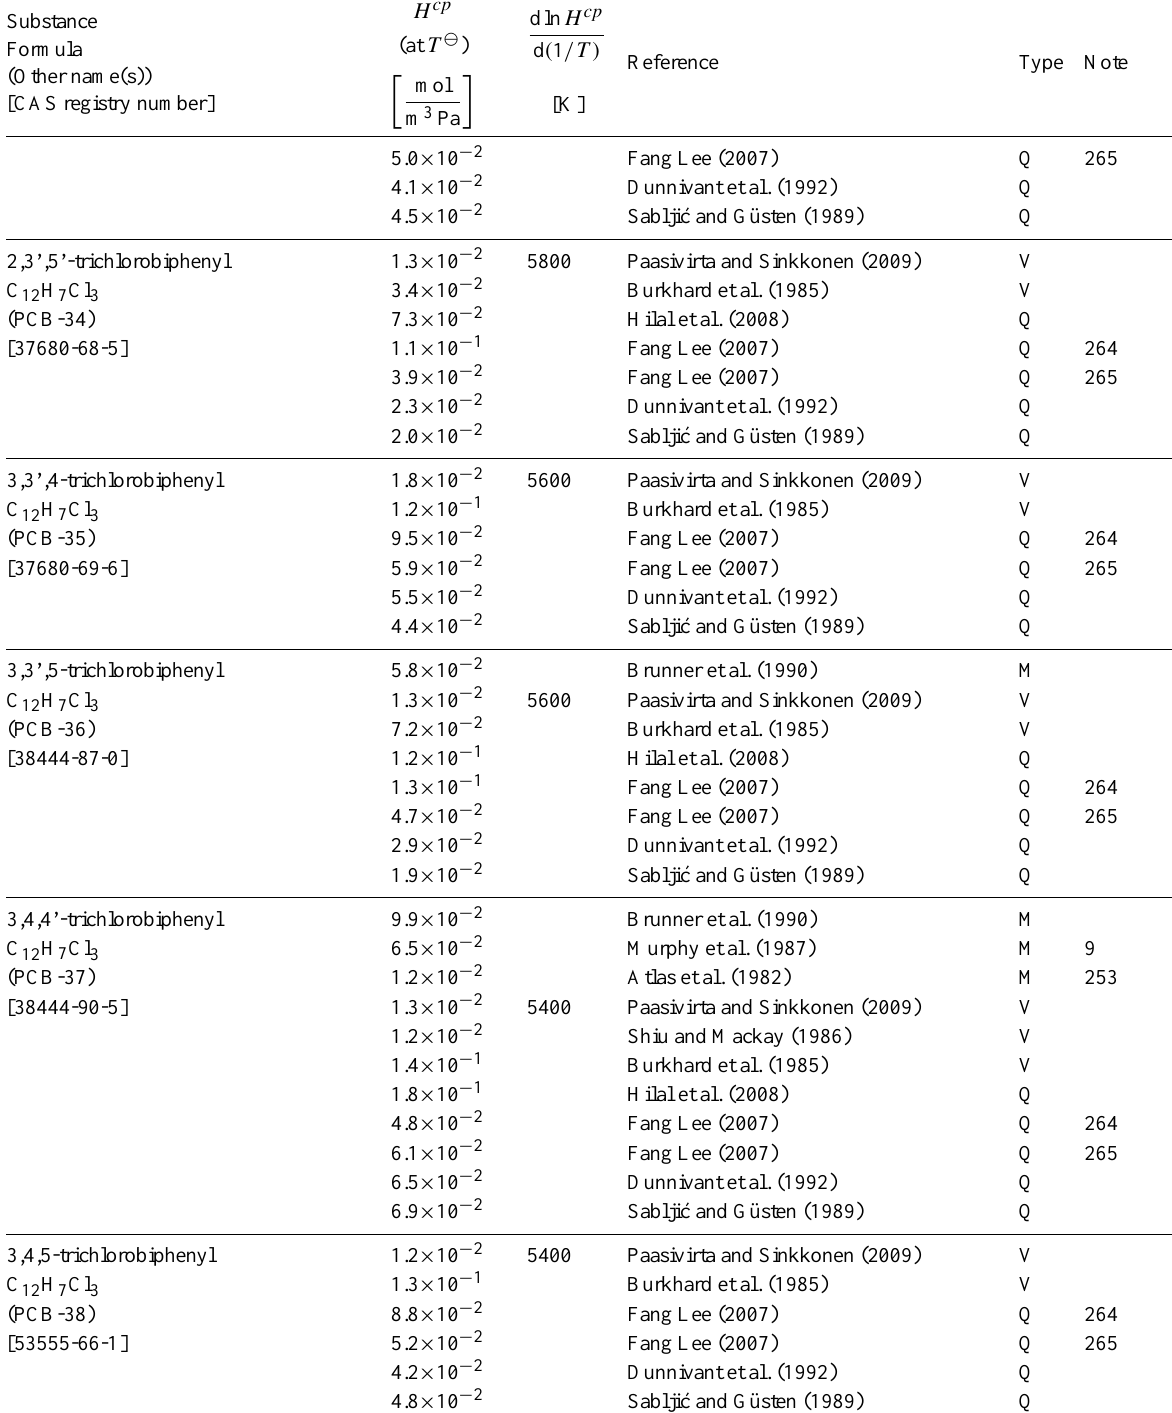
Table 6: Henry’s law constants for water as solvent